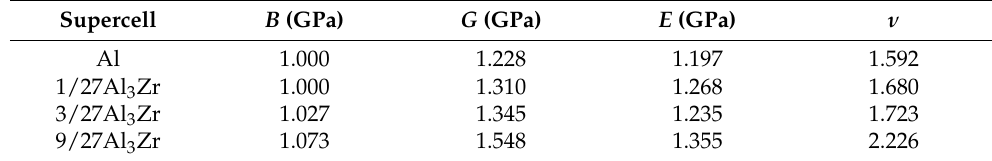
Table 3. The calculated anisotropy of bulk modulus B , shear modulus G , Young’s modulus E and Poisson’s ratio ν